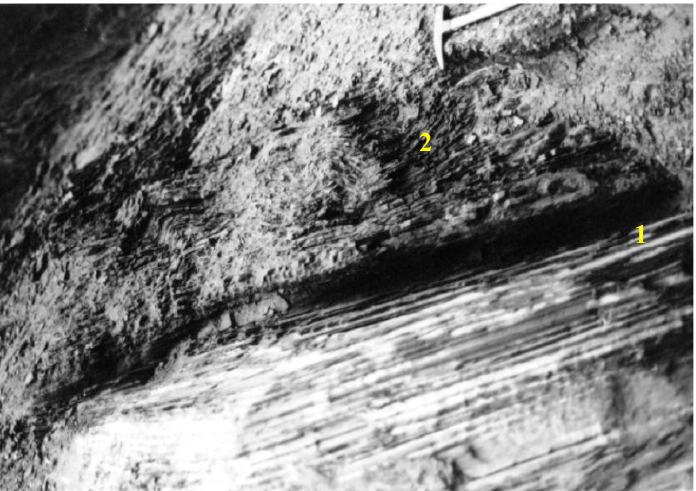
Figure 14. Contact between non-weathered/undeformed (1) and weathered/deformed (2) BIF—Pico Mine